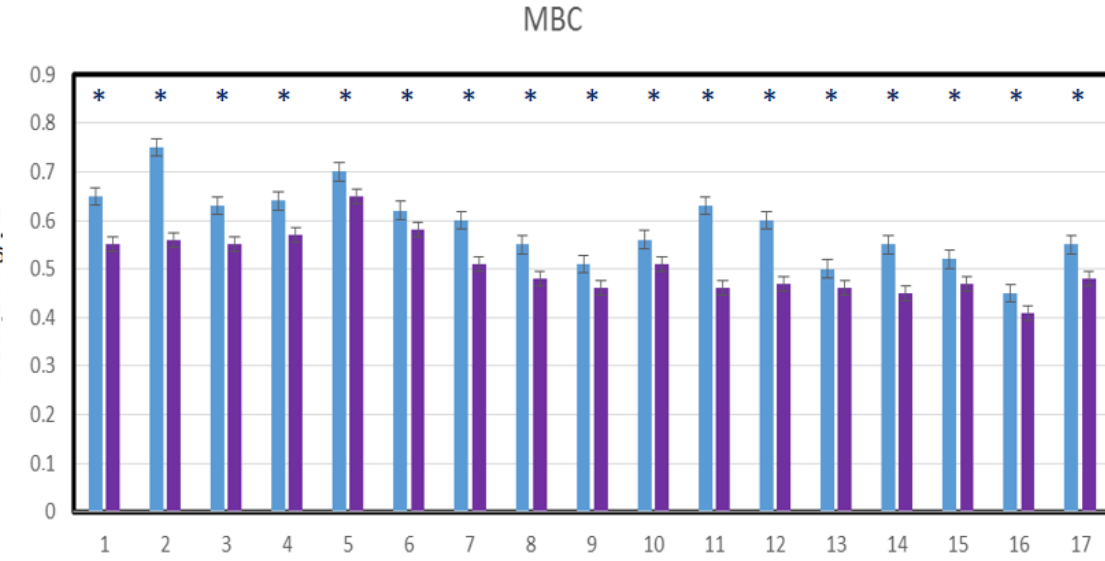
Figure 11. Virus particle analysis using MBC test (panel A- healthy volunteers without SARS-CoV-2) and (panel B- healthy volunteers after treatment of Salistat SGL03). Statistical significance vs. control in all analyzed samples were at * p < 0.05. X-axis number of study participants from 1 to 17.